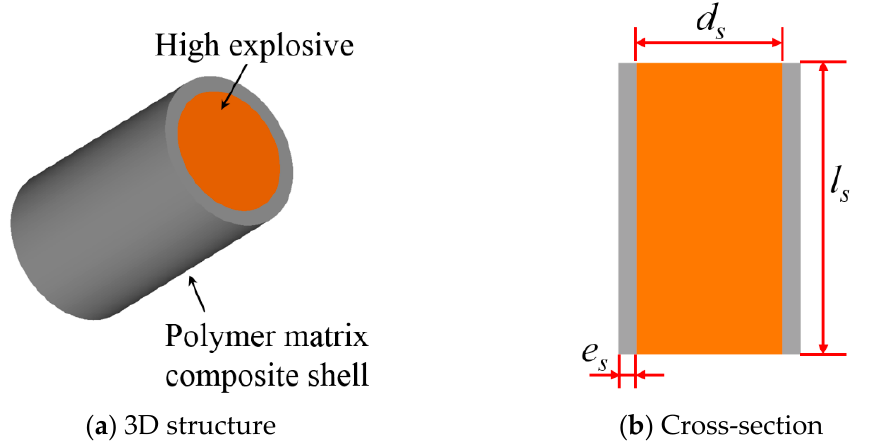
Figure 1. Structural diagram of a charge enveloped by a polymer matrix composite shell.